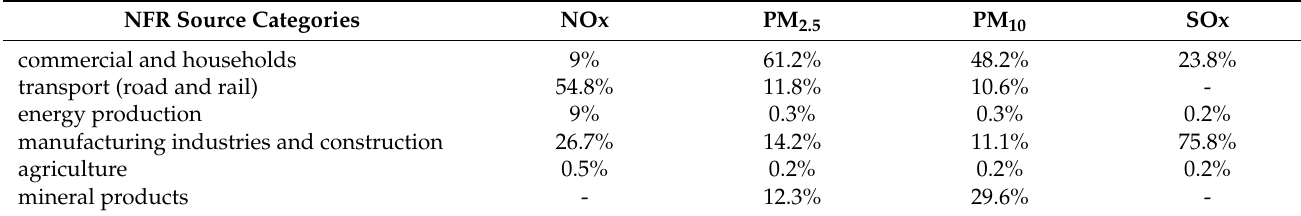
Table 3. Industrial sectors contributing to emission of air pollutants in